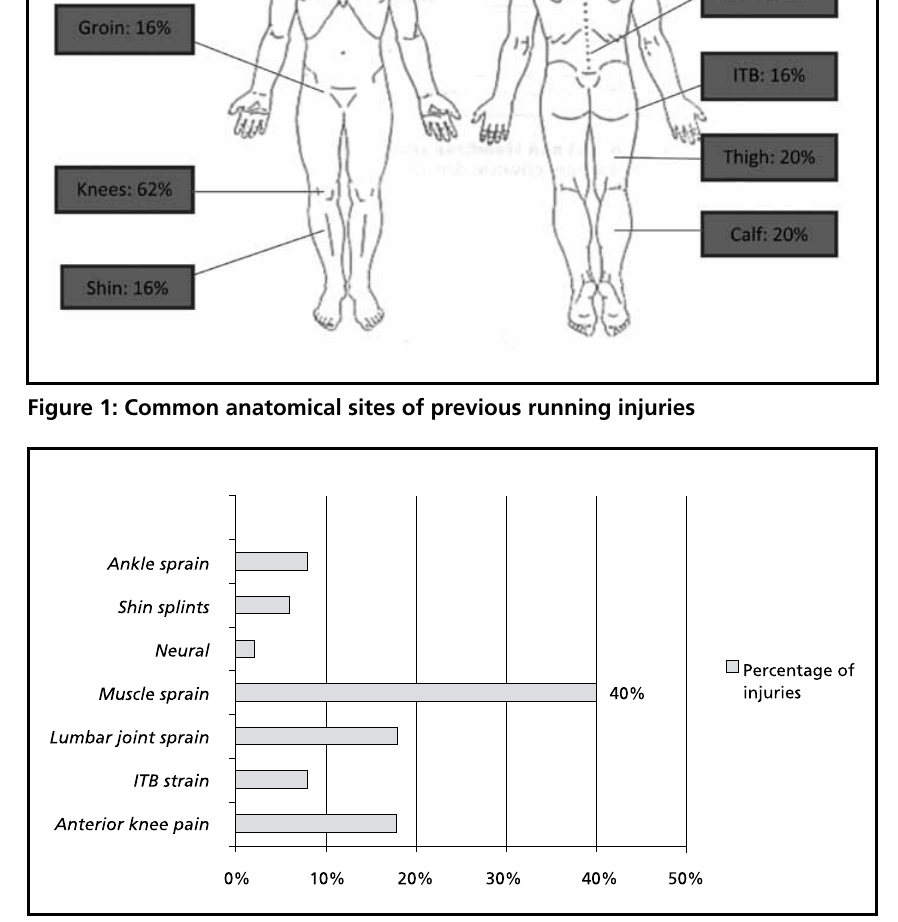
Figure 2: the proportion of types of running injuries sustained by